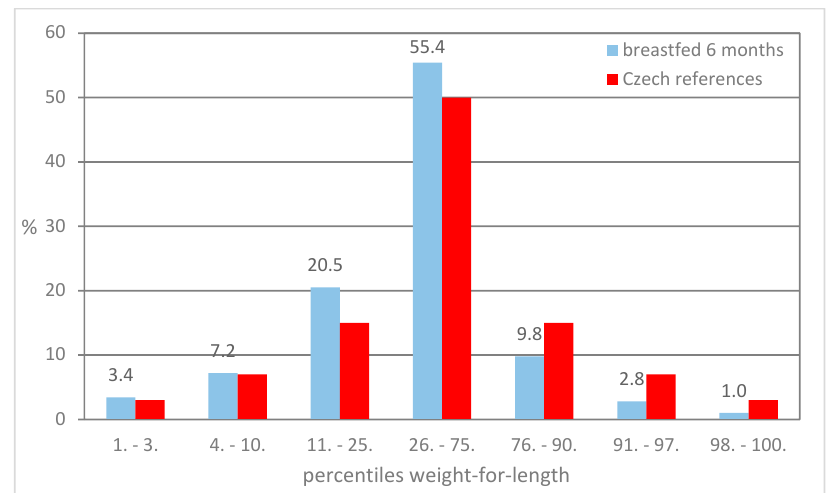
Figure 3. Proportion of children in the percentile categories of weight-for-length at 18 months.